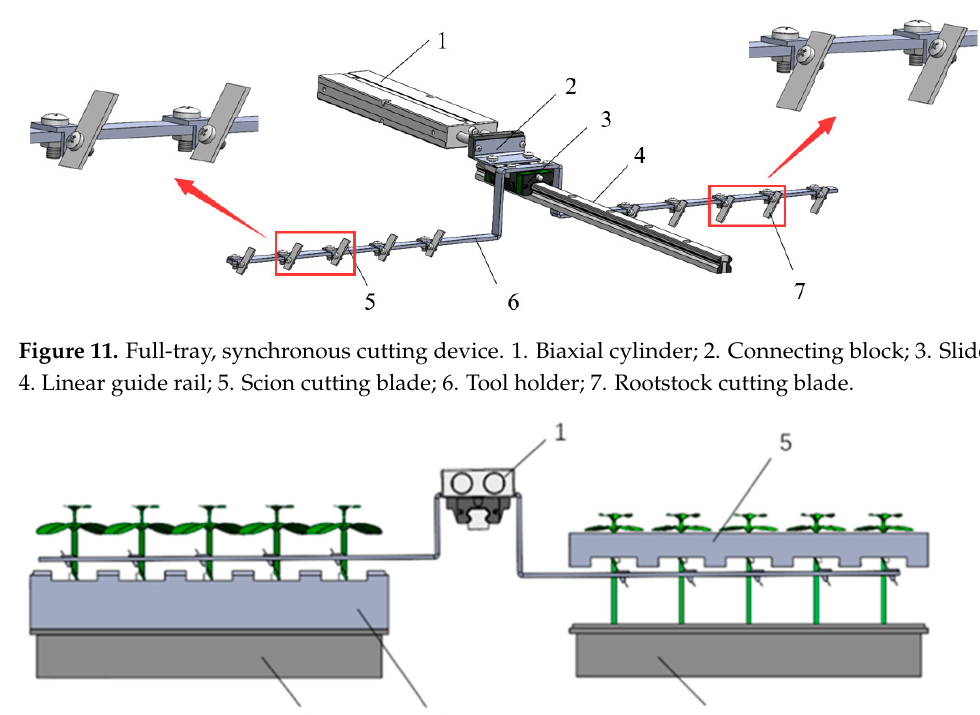
Figure 11. Full-tray, synchronous cutting device. 1. Biaxial cylinder; 2. Connecting block; 3. Slider;